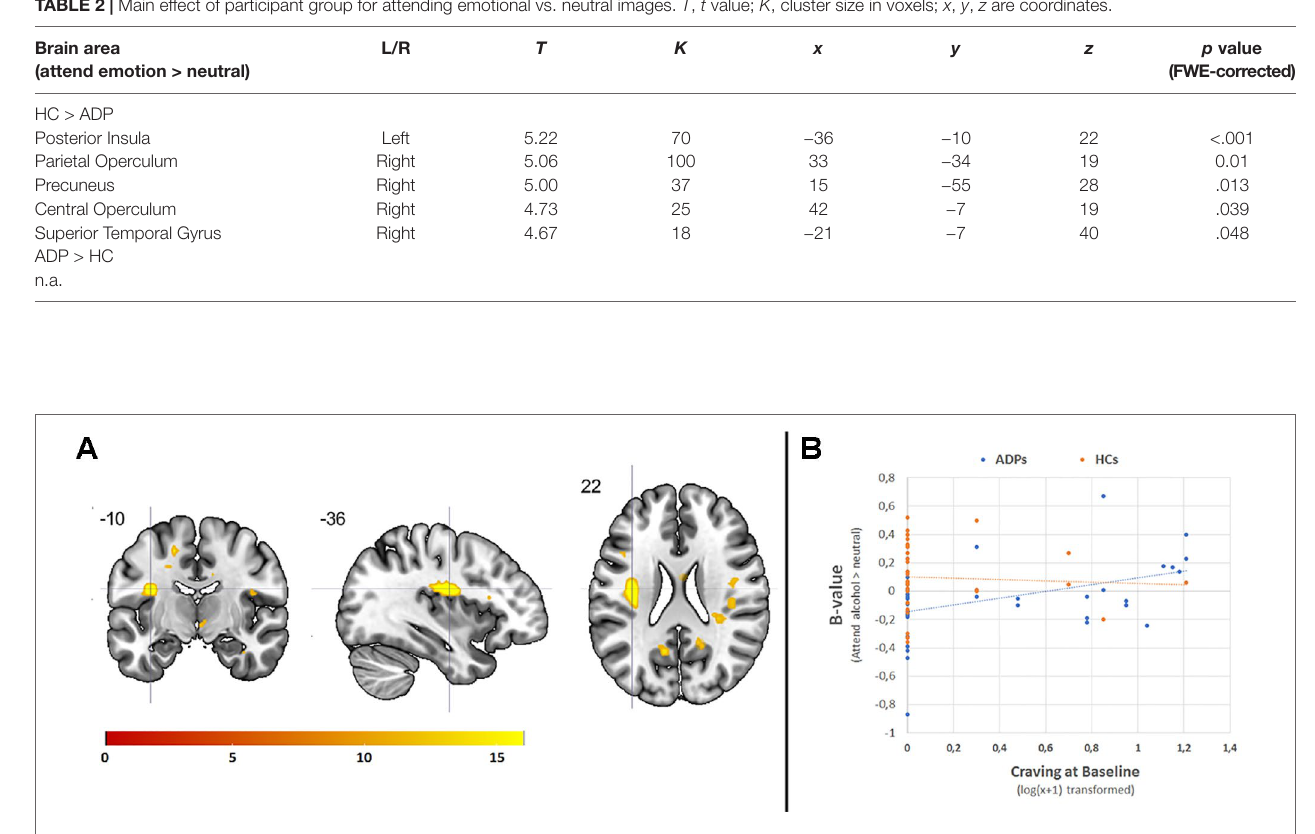
FIGURE 4 | (A) Graphical presentation of the increased activity in healthy controls (HCs) compared to alcohol-dependent patients (ADPs), during emotion processing (attending negative, positive, and alcohol-related images vs. neutral). Crosshair is pointed at the peak voxel in the posterior insula. (B) The correlation between the posterior insula and baseline craving levels for the [attend alcohol > neutral] contrast. The threshold for visualization of the results is set at k > 5, p < 0.001 uncorrected.